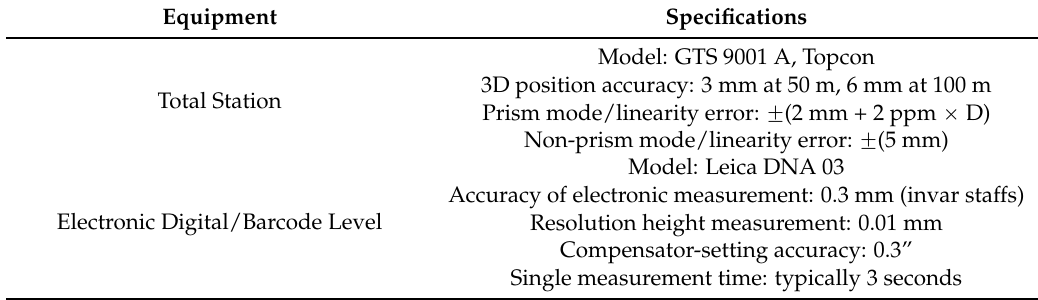
Table 2. Specifications of total station and electronic digital/barcode level.